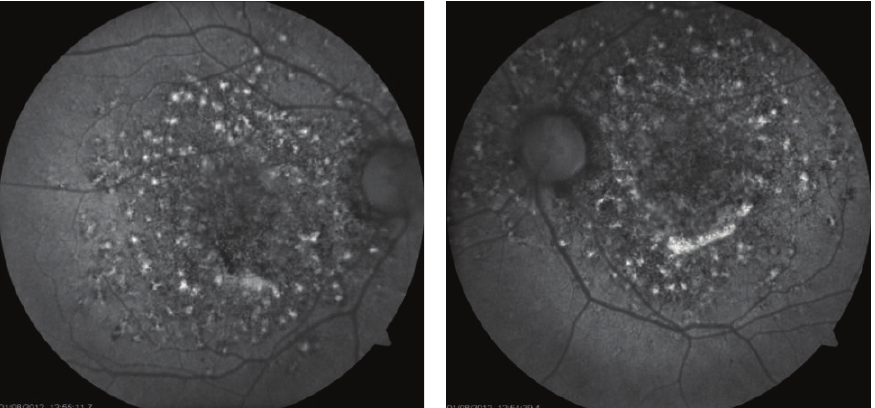
Figure 5: Fundus